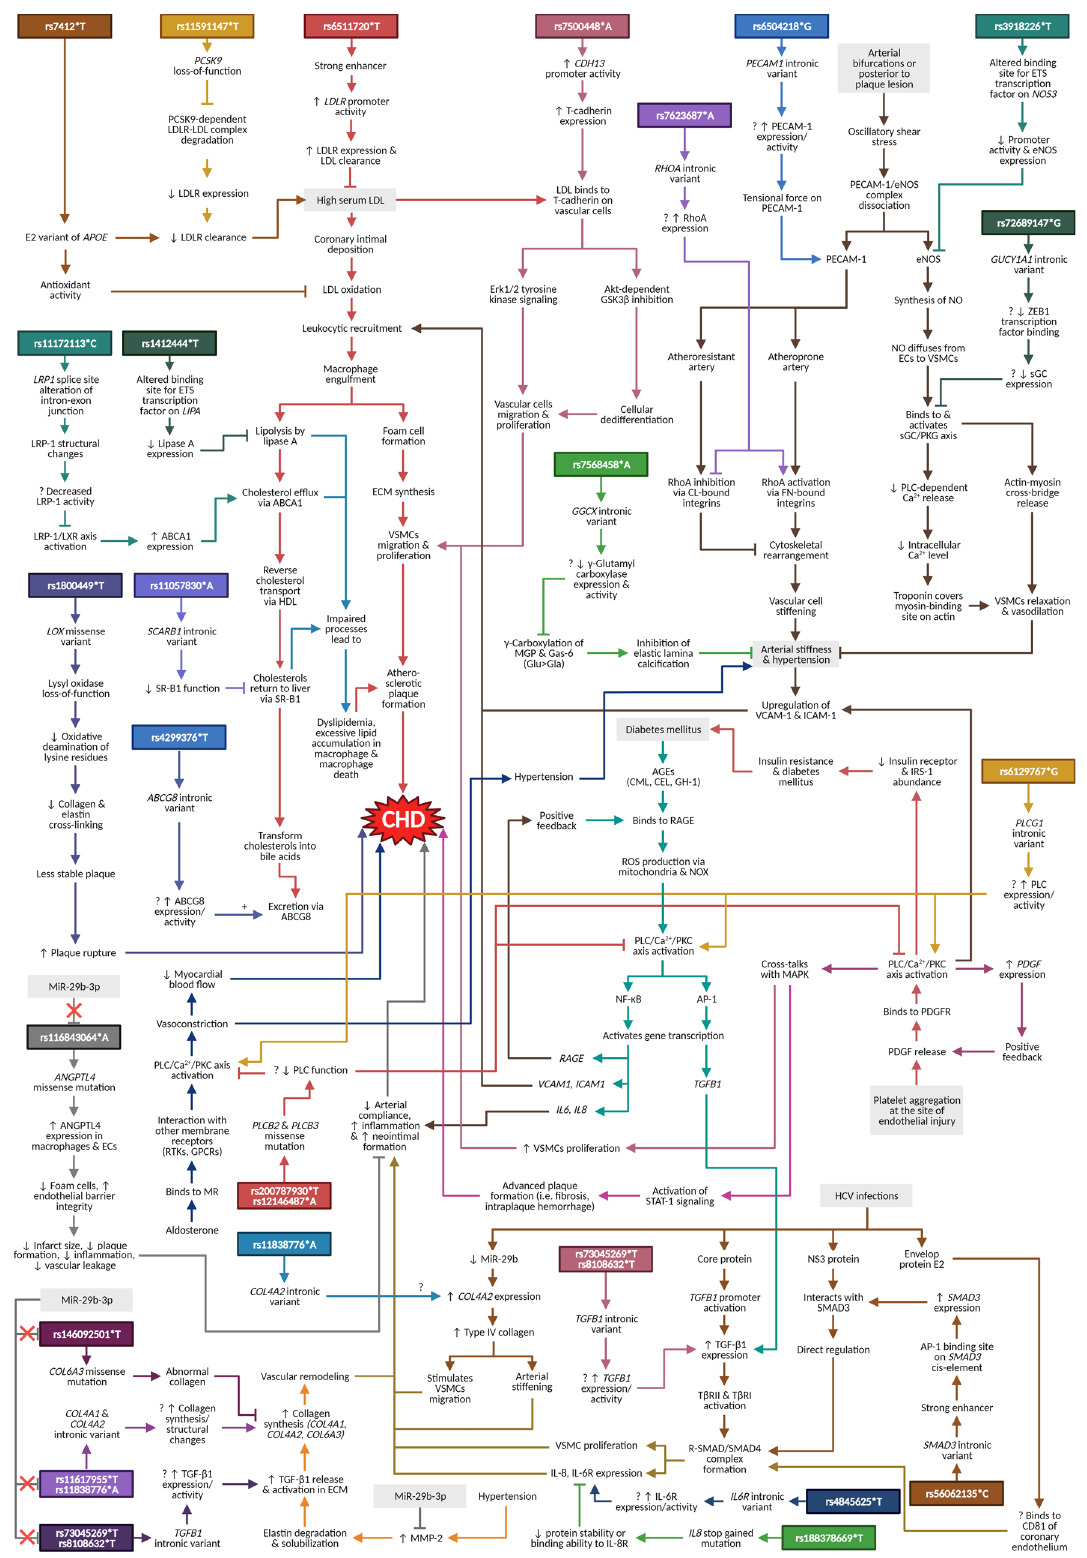
Figure 3. Selected single-nucleotide polymorphisms from pathway enrichment analysis and their proposed mechanisms with either positive or negative associations leading to coronary heart disease.